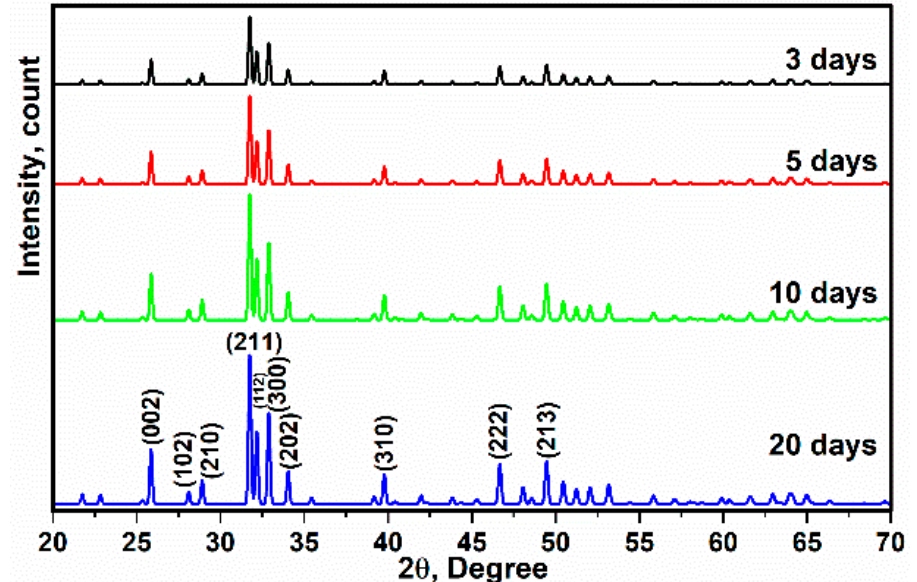
Figure 14. X-ray diffraction of immersed scaffold in SBF after 3, 5, 10 and 20 days.